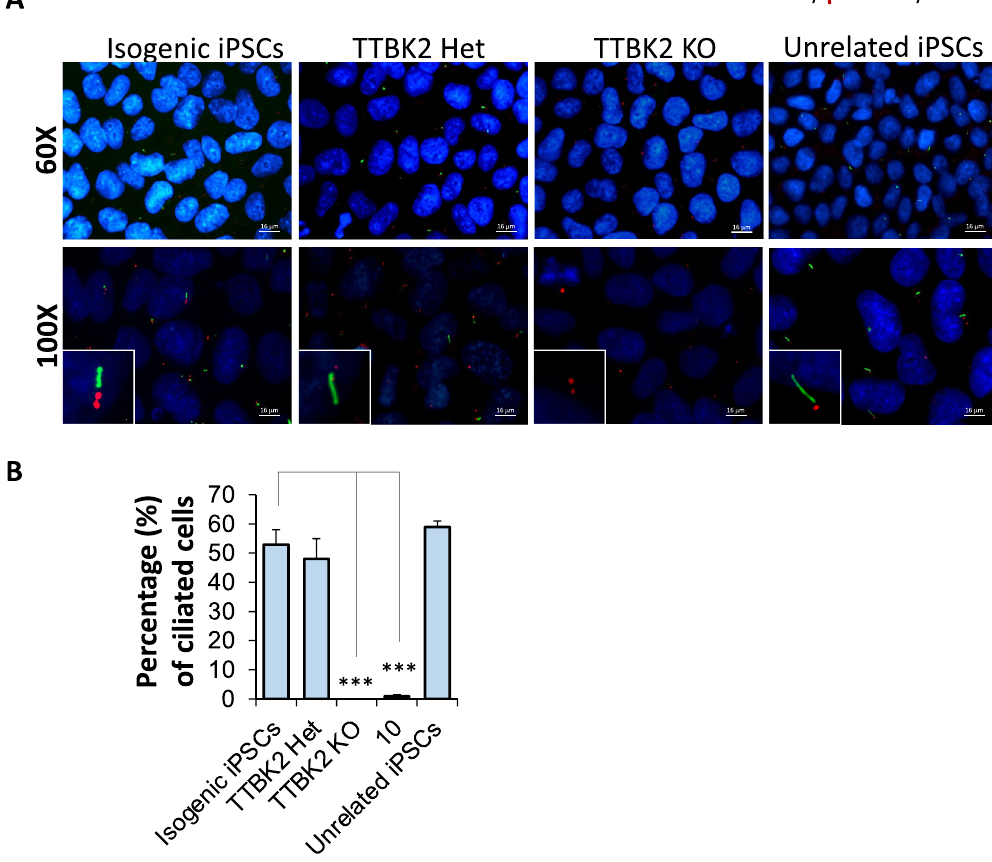
Figure 7. Images and quantification of cilia on human iPSCs compared to TTBK2 KO iPSCs and iPSCs treated with 10 . ( A ) Visualization of cilia on human isogenic iPSCs, TTBK2 Het cells,TTBK2 KO cells, and an unrelated iPSC line (UNCC1001-A) following 72 h starvation. A legend of the stains used to visualize cilia and nuclei is placed above the panels. Primary cilia are labeled with the Arl13b antibody (green), centriole with γ-tubulin (red), and the nuclei with DAPI (blue). Images were taken at 60X (top panels, scale bar 16 µm) or at 100X (bottom panels, scale bar 10 µm). Insets in the bottom panels more clearly show cilia corresponding with each cell line. ( B ) Plot of the percentage of cells expressing cilia averaged from ten random visual fields for human isogenic iPSCs, TTBK2 Het cells, TTBK2 KO cells, and an unrelated iPSC line (UNCC1001-A) versus percentage of cells expressing cilia averaged from six random visual fields following 72 h continuous treatment with 1 µM of 10 . Error bars represent the SEM and p -values calculated by comparing the percentage of cells expressing cilia from three different biological experiments using one-way ANOVA. *** p -value <